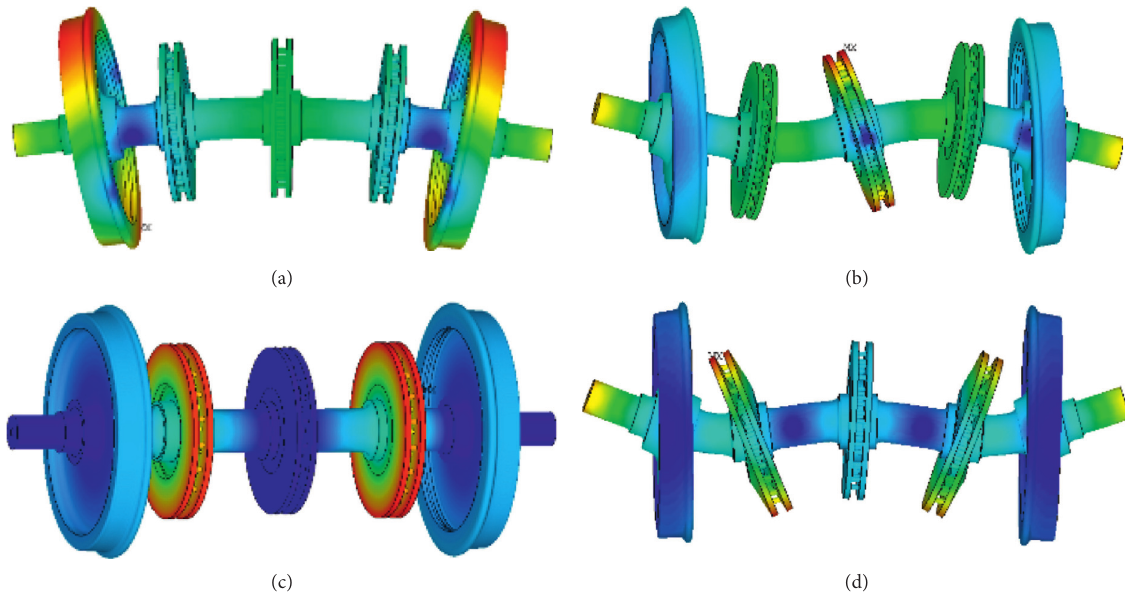
Figure 9: Main modal shapes of the wheelset. (a) The first-order bending mode (82 Hz), (b) the second-order bending mode (393 Hz), (c) the torsional mode (432 Hz), and (d) the third-order bending mode (624